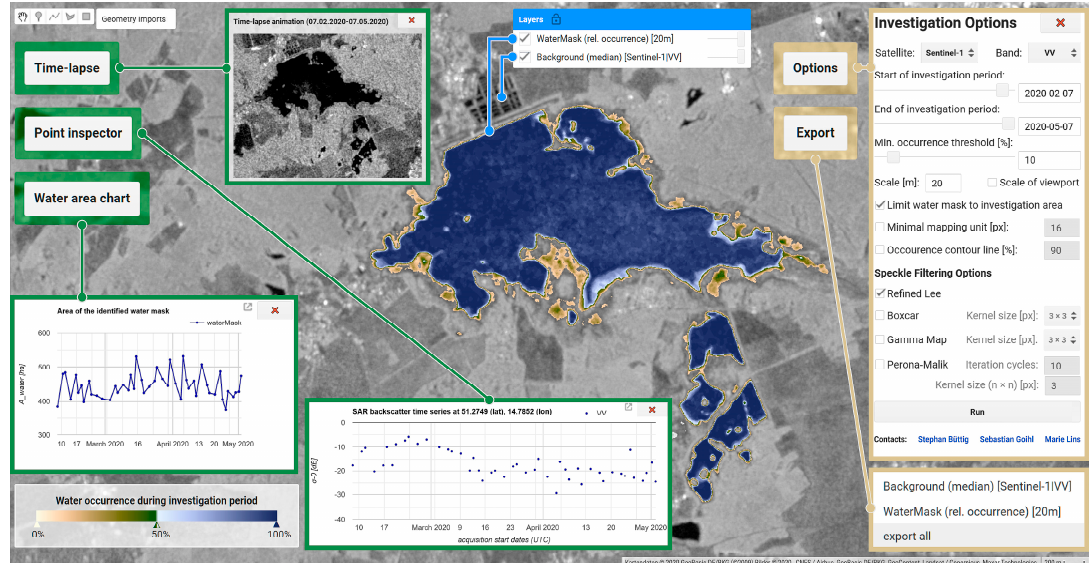
Figure 5. Post-processing map view of WMA.